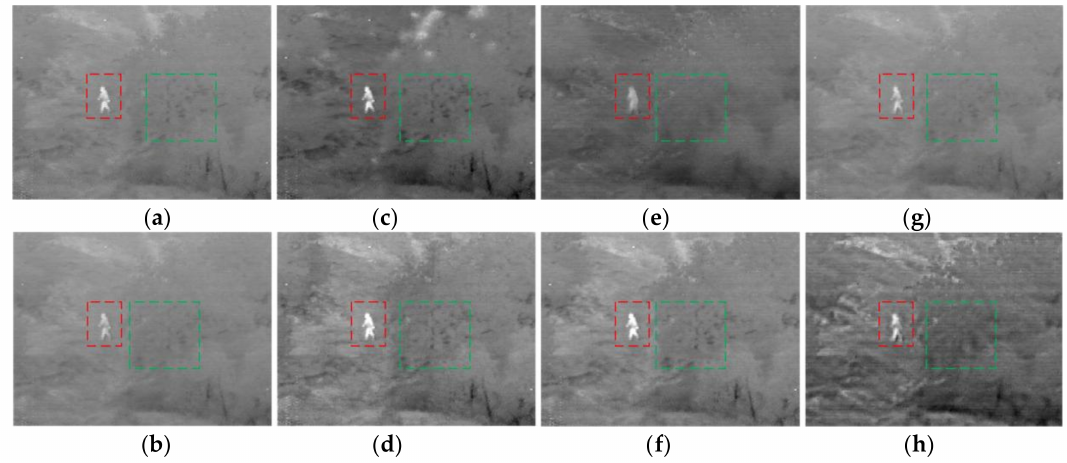
Figure 7. The results for third set of images. ( a ) CP; ( b ) PCA; ( c ) GFF; ( d ) SAL; ( e ) GTF; ( f ) NSCT; ( g ) NSST; and ( h ) proposed.